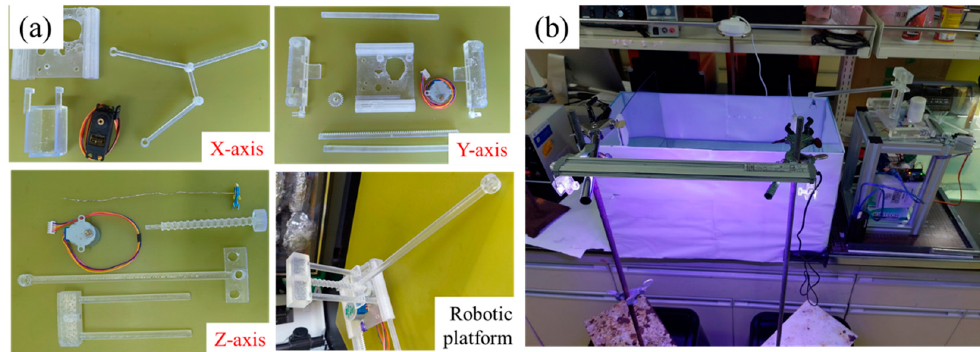
Figure 2. ( a ) Homemade robotic components for different axes. ( b ) The homemade system for evaluating shoaling behavior of zebrafish.